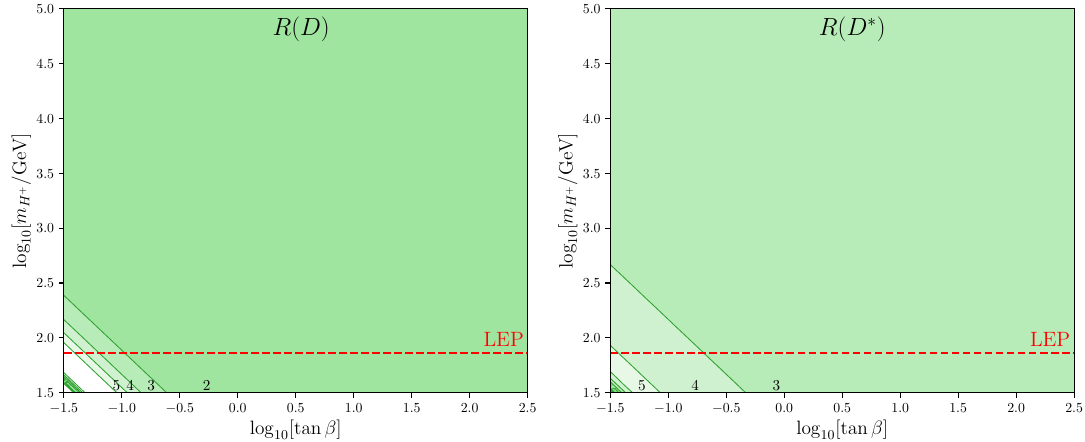
Figure 2 . Contour plots of the allowed 2HDM-I parameter space in the ( tan β − m ) plane for H + R ( D ) (left) and R ( D ∗ ) (right). Contours are shown representing allowed parameter space at 1, 2, 3, 4, 5 σ confidence from darkest to lightest; the confidence in σ is also written inside each contour region for clarity (outside the tiny regions in the very lower left of the plots). The red dashed line indicates the LEP lower bound for m in the Type I 2HDM ( 72 . 5 H +